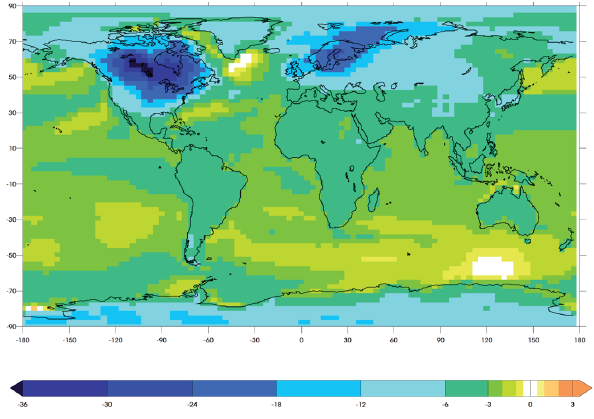
Fig. 1. Difference in mean annual temperature ( ◦ C) be- tween present-day and LGM (LGMP-CTRLP) simulated by the IPSL CM4 v1 GCM.